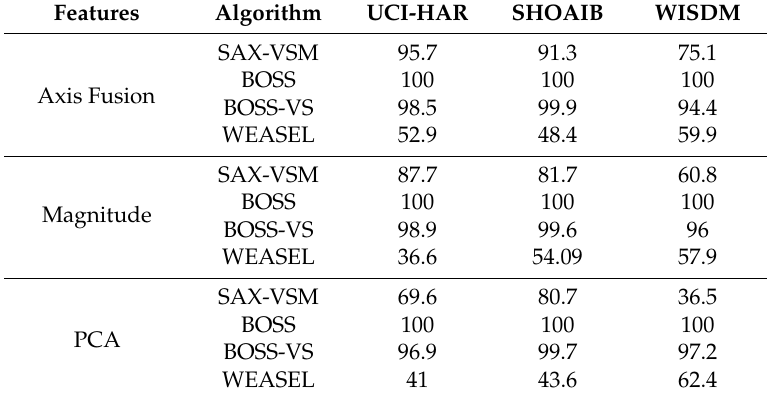
Table 4. Results regarding the accuracy of the classification models generated by the symbolic representation algorithms using the coordinate fusion strategies for histogram stacking, magnitude, and PCA.